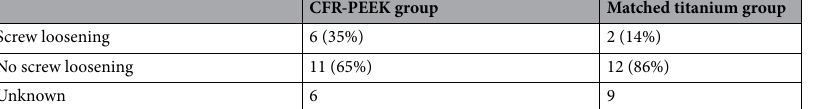
Table 3. Rate of screw loosening of CFR-PEEK group and matched titanium group. Number of cases with screw loosening detected in follow up imaging. To compare the groups Chi 2 -test was used. p =